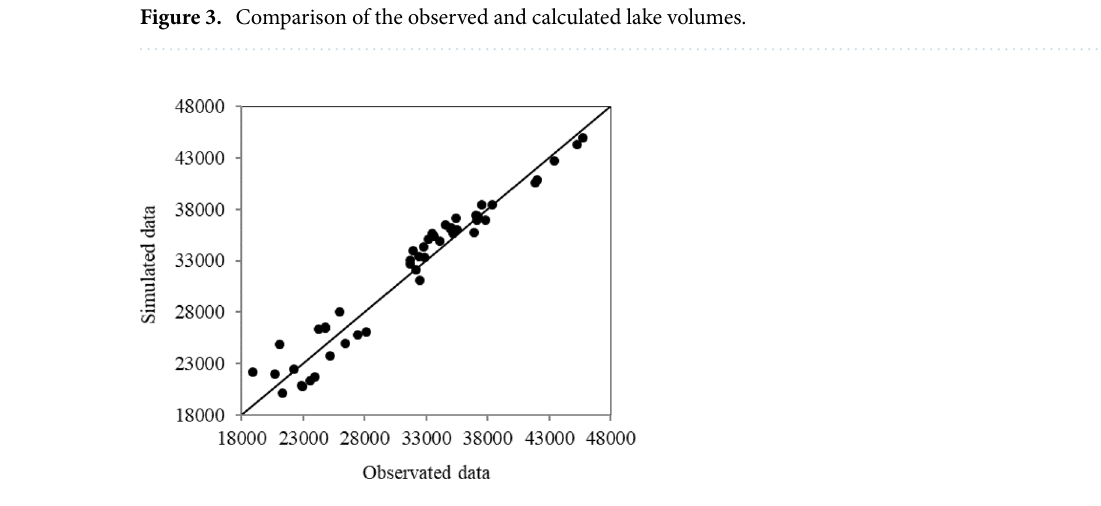
Figure 4. Scatter plot of the simulated and observed lake